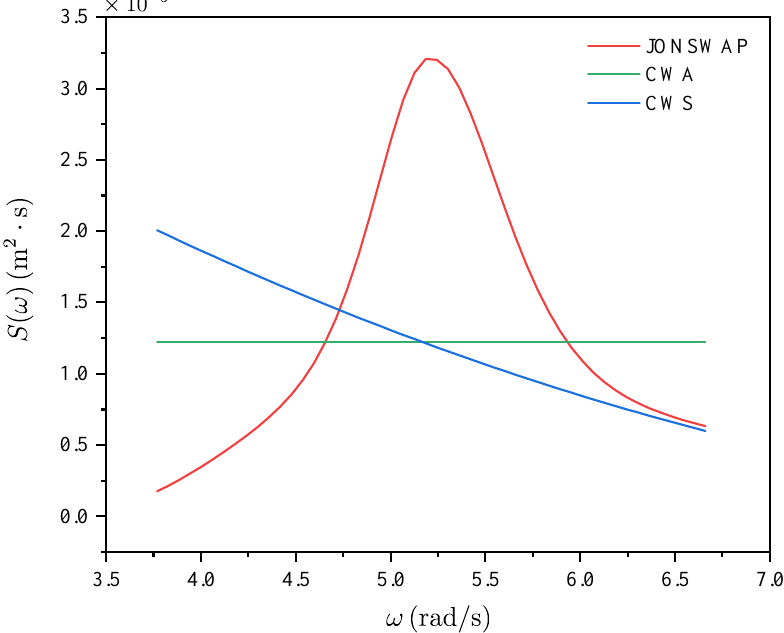
Figure 10. JONSWAP, CWA and CWS spectrum given for the comparison study (color figure available online).